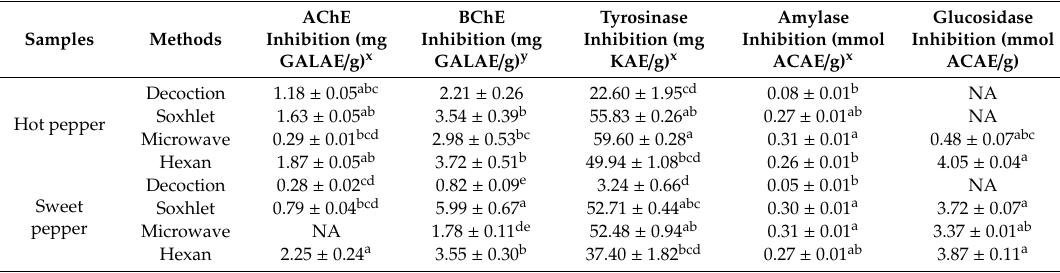
Table 4. Enzyme inhibitory properties of the tested